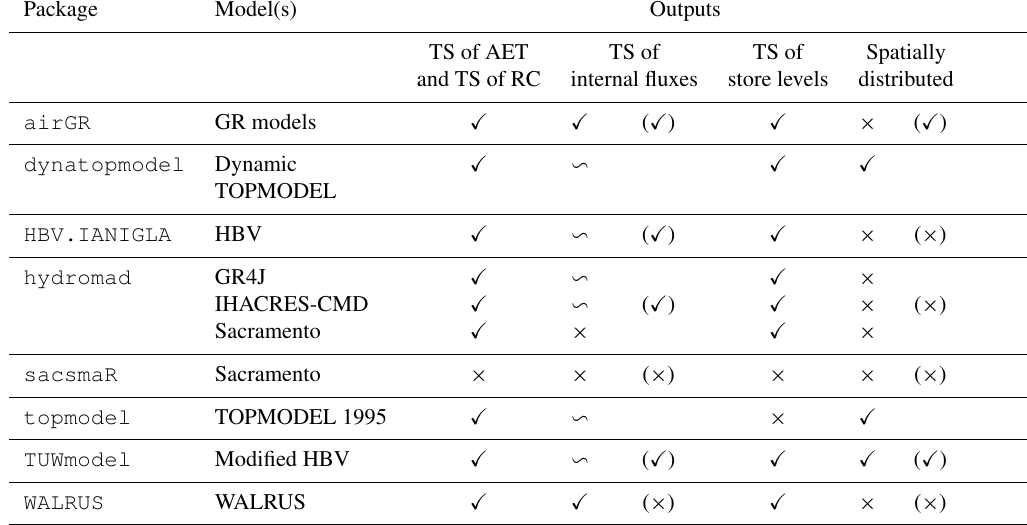
Table 5. Model outputs made available by the packages. Note: TS – time series; AET – actual evapotranspiration; RC – runoff components. The tilde ( (cid:118) ) indicates that only some of the time series of runoff components, internal fluxes or store levels are provided. The information in parentheses shows the outputs of the corresponding snow routine. All the packages return a time series of